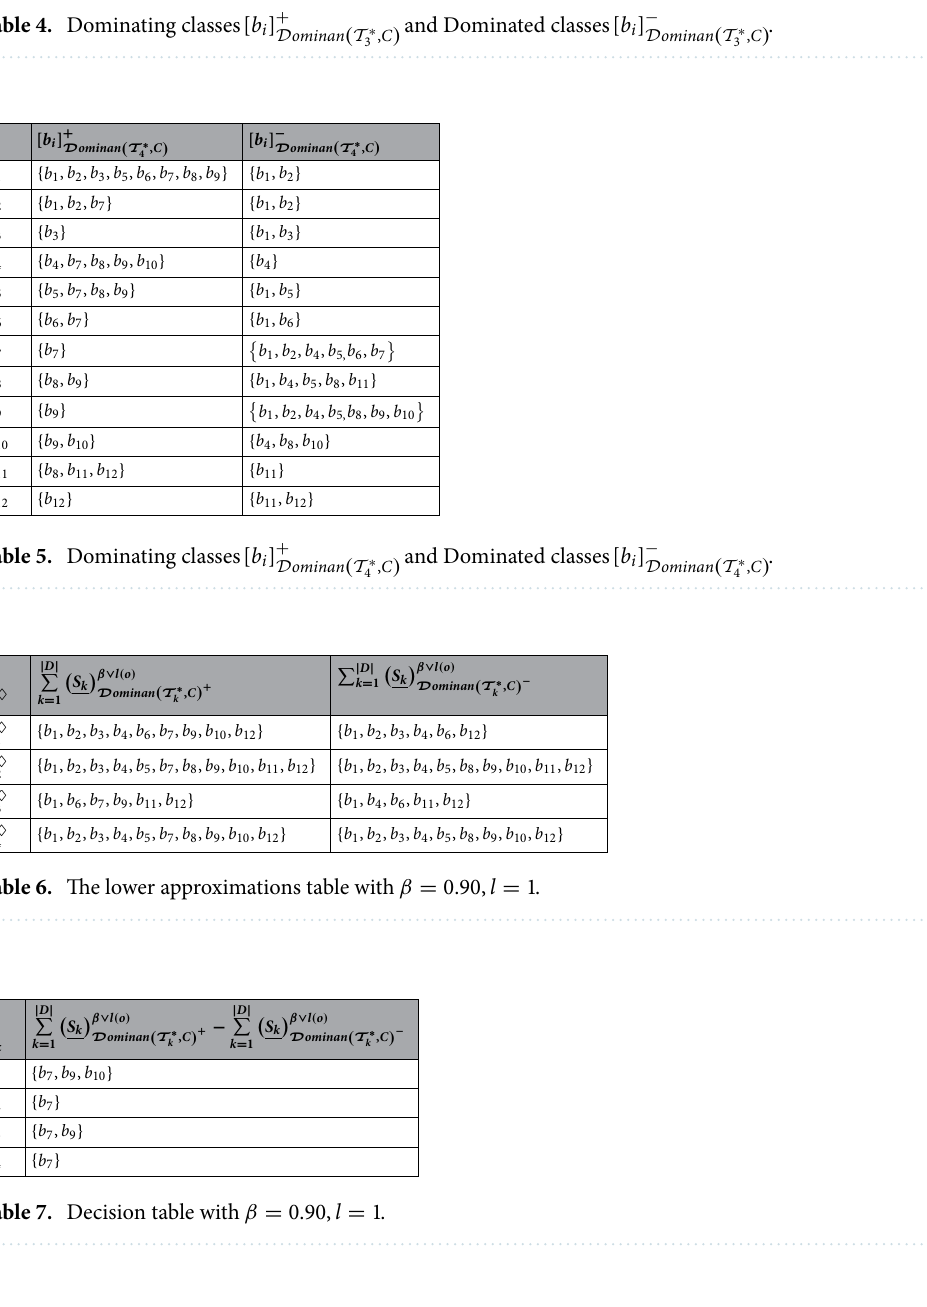
C ) and Dominated classes 3 ,